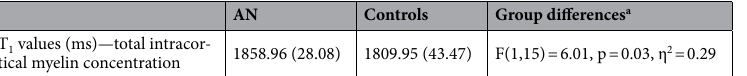
Table 2. Global T 1 values across individuals with AN and controls: Analysis of Covariance. Mean (standard deviation) of average T 1 values across all ten cortical depth-levels. Group differences in terms of F value (degrees of freedom), p value and effect size are shown. a Analysis corrected for age.